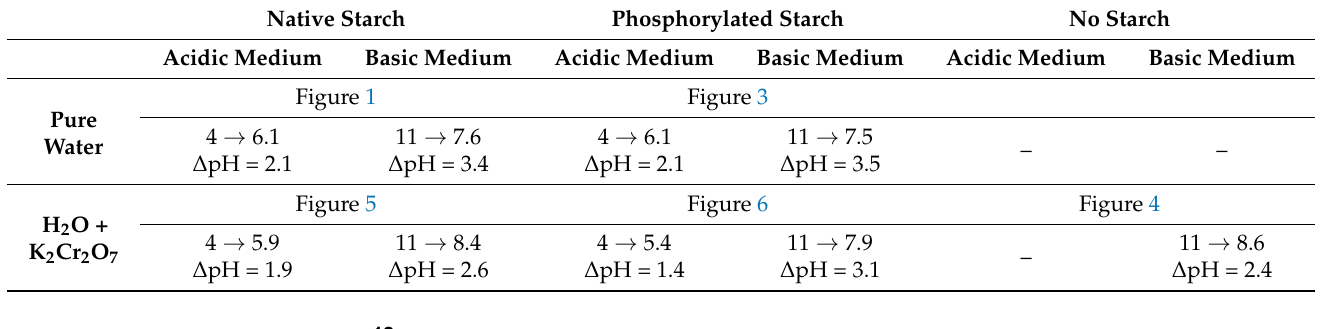
Table 1. Collected data from Sections 2.1–2.4 concerning pH changes in water suspensions of the native and phosphorylated starch as a function of time.